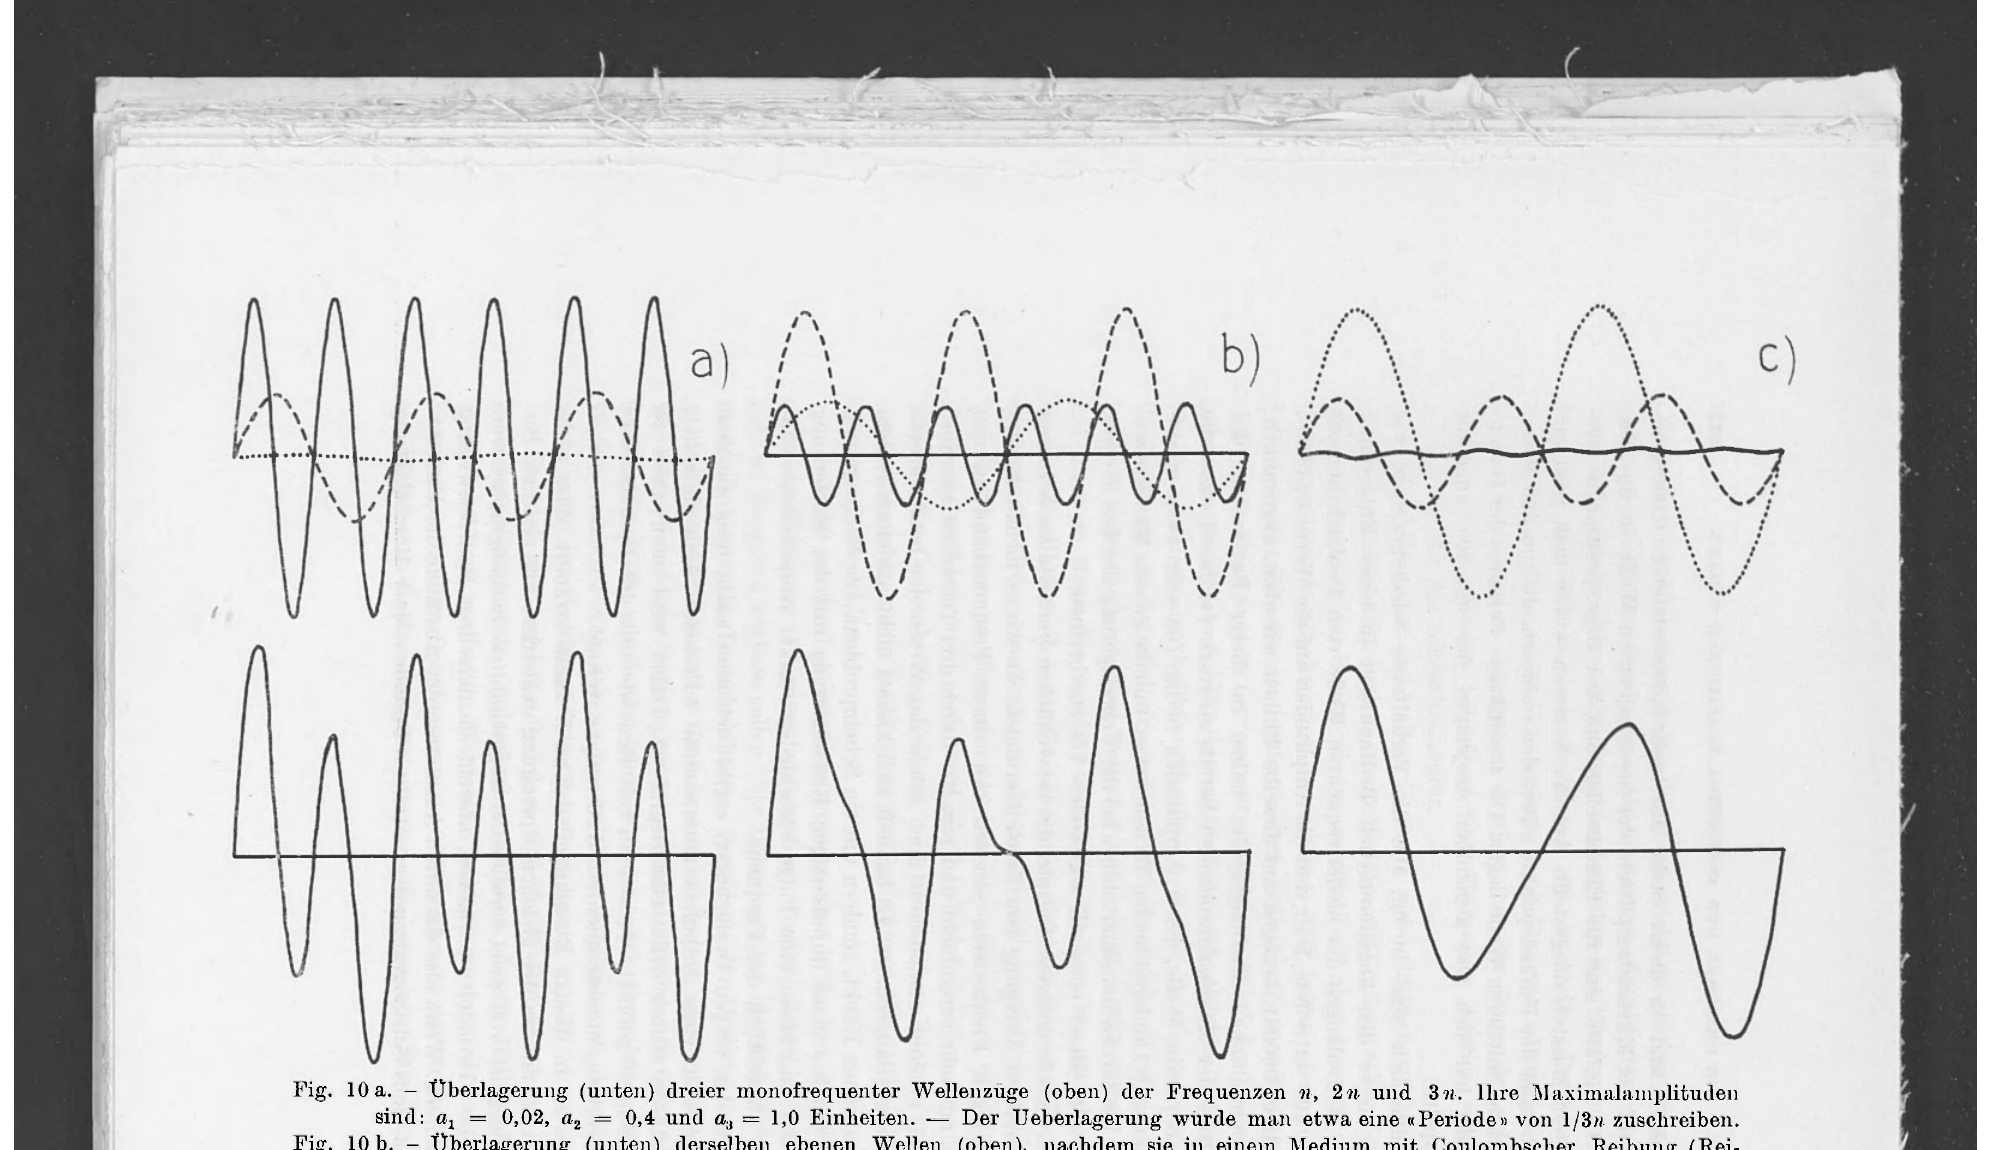
Fig. 10 a. - Uberlagerung (unteli) dreier monofrequenter Wellenzuge (oben) der Frequenzen n, 2 n und 3 n. llire Maximaìamplituden sind: cq = 0,02, a 2 = 0,4 und a. ò = 1,0 Einbeiten. — Der Ueberlagerung wurde man etwa eine «Periode» von 1/3» zusclireiben. Fig. 10 b. - Uberlagerung (unten) derselben ebenen Wellen (oben), nachdem sie in einein Medium mit Coulombscher Reibung (Rei- bungskoeffizient r = 0,1) eine Entfernung von 10 Wellenlàngen der niederfrequenten Welle mit gleicher Gescliwindigkeit zurùckgelegt haben. Die Maximaìamplituden berechnen sich nun zu: «j = 0,0027, a 2 = 0,0072 und a 3 = 0,0025 Einheiten von Fig. 10 a. Hier wurde man der Uberlagerung eine «Periode» von ungefahr l/2n zusprechen. Fig. 10 c. - Uberlagerung (unten) der gleichen Wellen (oben) nach weiteren 10 Wellenlàngen der niederfrequenten Welle. Die Maxima- ìamplituden haben auf die Werte a l = 0,00036, a 2 = 0,00014 und a 3 = 0,0000061 Einheiten abgenommen. Die Uberlagerung besitz jetzt die «Periode»